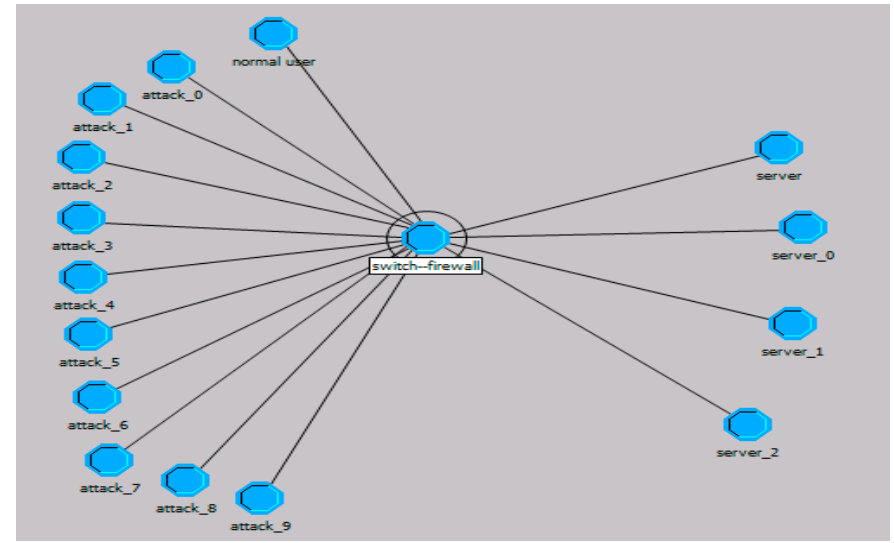
Figure 17. Incomplete minority game (IMG) model of the network topology map.